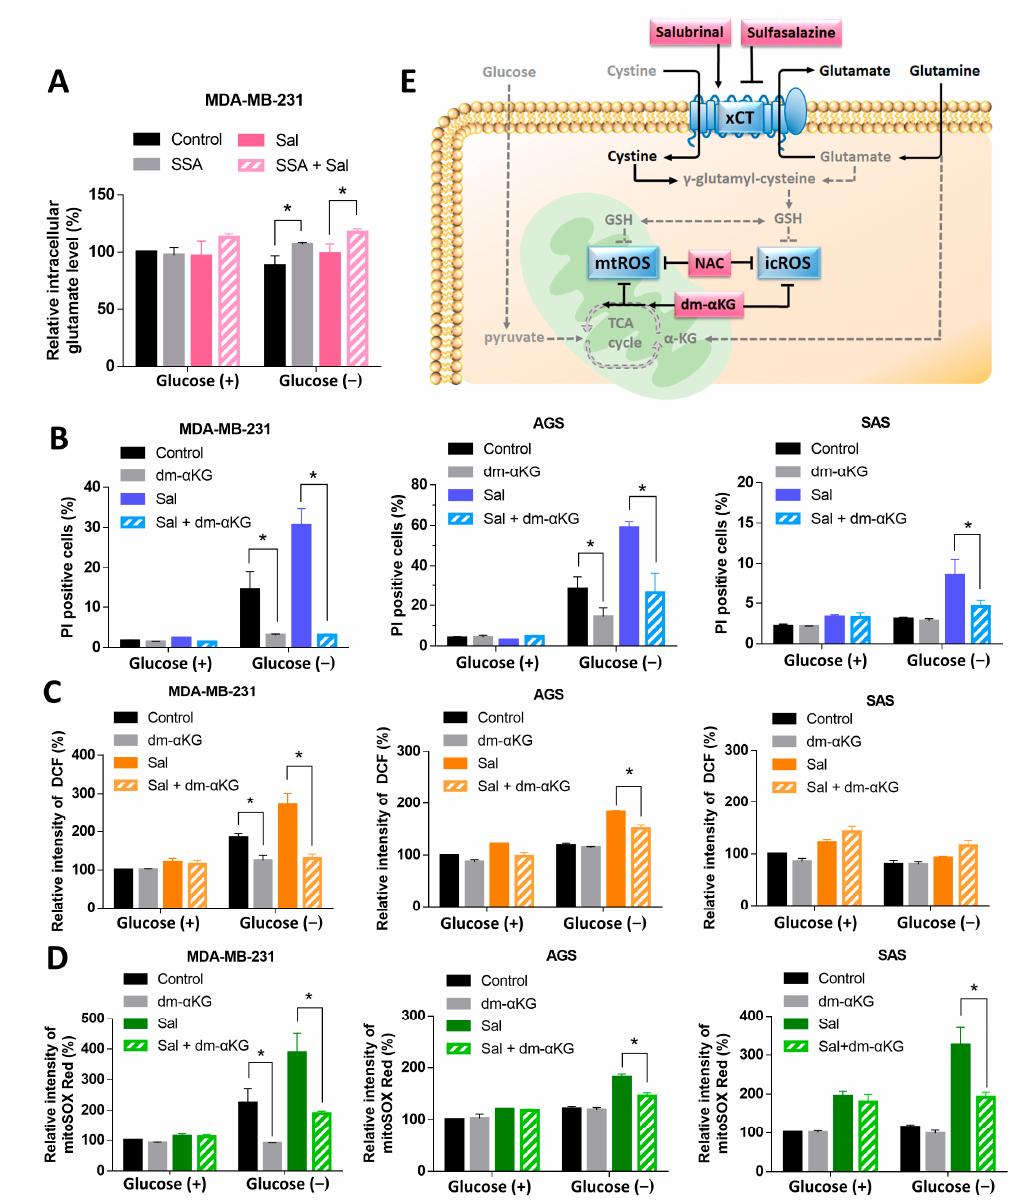
Figure 5. Dm- α KG improved the salubrinal-enhanced cell death and decreased the levels of mtROS during glucose deprivation. ( A ) Intracellular glutamate levels of MDA-MB-231 were detected using a glutamate assay kit. The measured level of glutamate in the control group under glucose-containing conditions was normalized at 100%. The cells were treated according to the study design with or without 30 µ M of salubrinal and/or 4 mM of dm- α KG for 24 h. ( B ) The cell death rate was evaluated by a PI exclusion assay. The levels of intracellular ROS (icROS) and mitochondrial ROS (mtROS) were detected using flow cytometry with DCFH-dA staining ( C ) and mitoSOX Red dye ( D ). The measured value of ROS from the control group under glucose-containing conditions was normalized as 100%. ( E ) Model of the mechanism of salubrinal enhanced-cell death during glucose deprivation. Salubrinal and glucose deprivation synergic increased the levels of mtROS through enhancing the expression of xCT with nutrient deficiency-related oxidative stress. Sulfasalazine, NAC, and dm- α KG were found to reverse salubrinal enhanced-cell death during glucose deprivation. Dash line arrows means the attenuation effects when glucose deprivation. Solid line arrows indicates the enhanced effects when glucose deprivation. T shape lines means inhibitory effects when treating with sulfasalazine, NAC, and dm- α KG. The data are presented as the means ± SEMs of the results from three independent experiments. * p < 0.05. dm- α KG: dimethyl- α -ketoglutarate. Sal: salubrinal. Glucose (+): medium with 25 mM of glucose. Glucose ( − ): glucose-free medium. GSH: glutathione. icROS: intracellular ROS. mtROS: mitochondrial ROS. NAC: